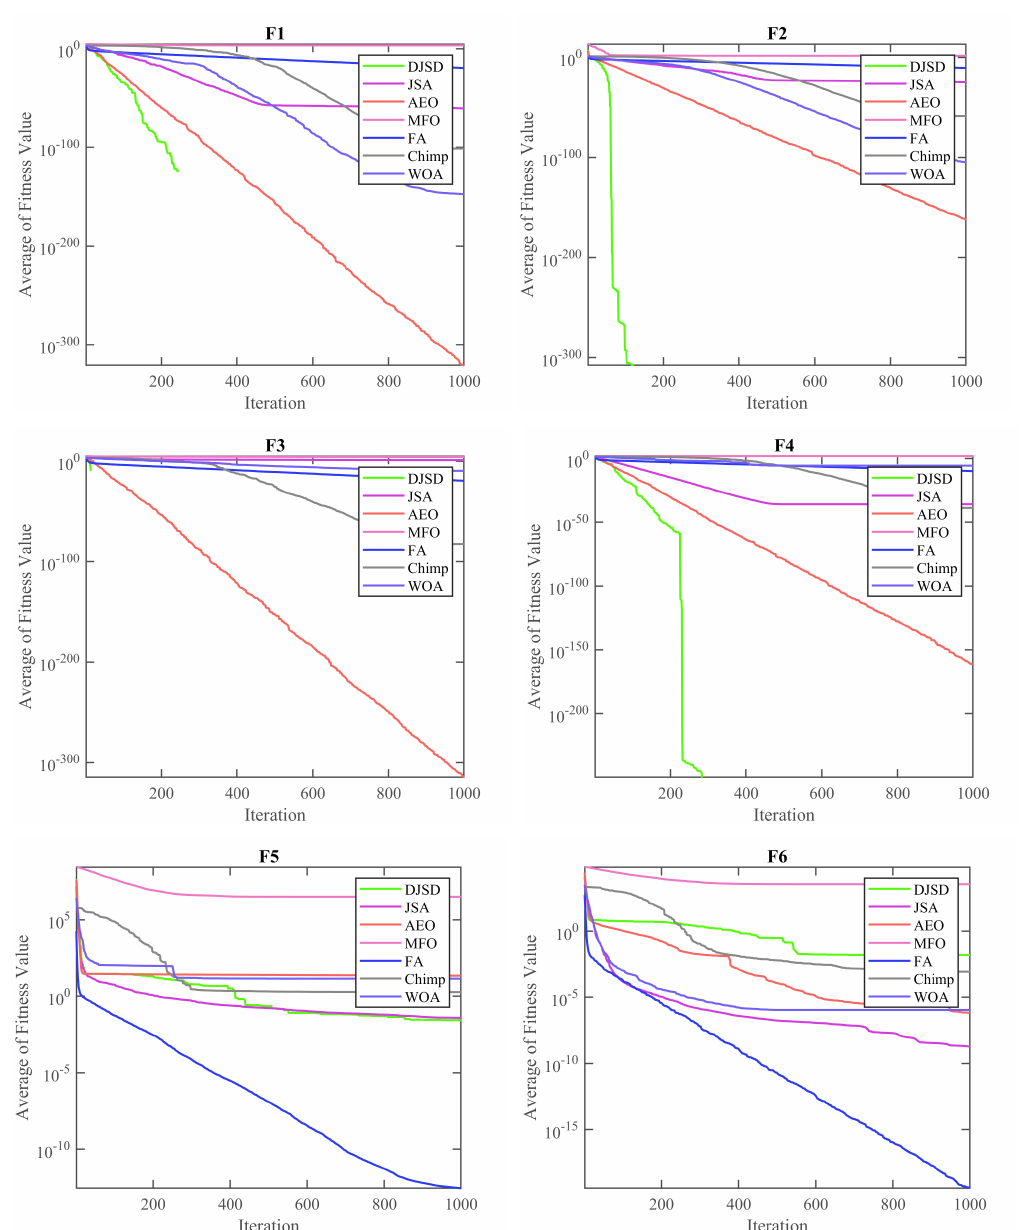
Figure 2. Convergence curves of each approach for